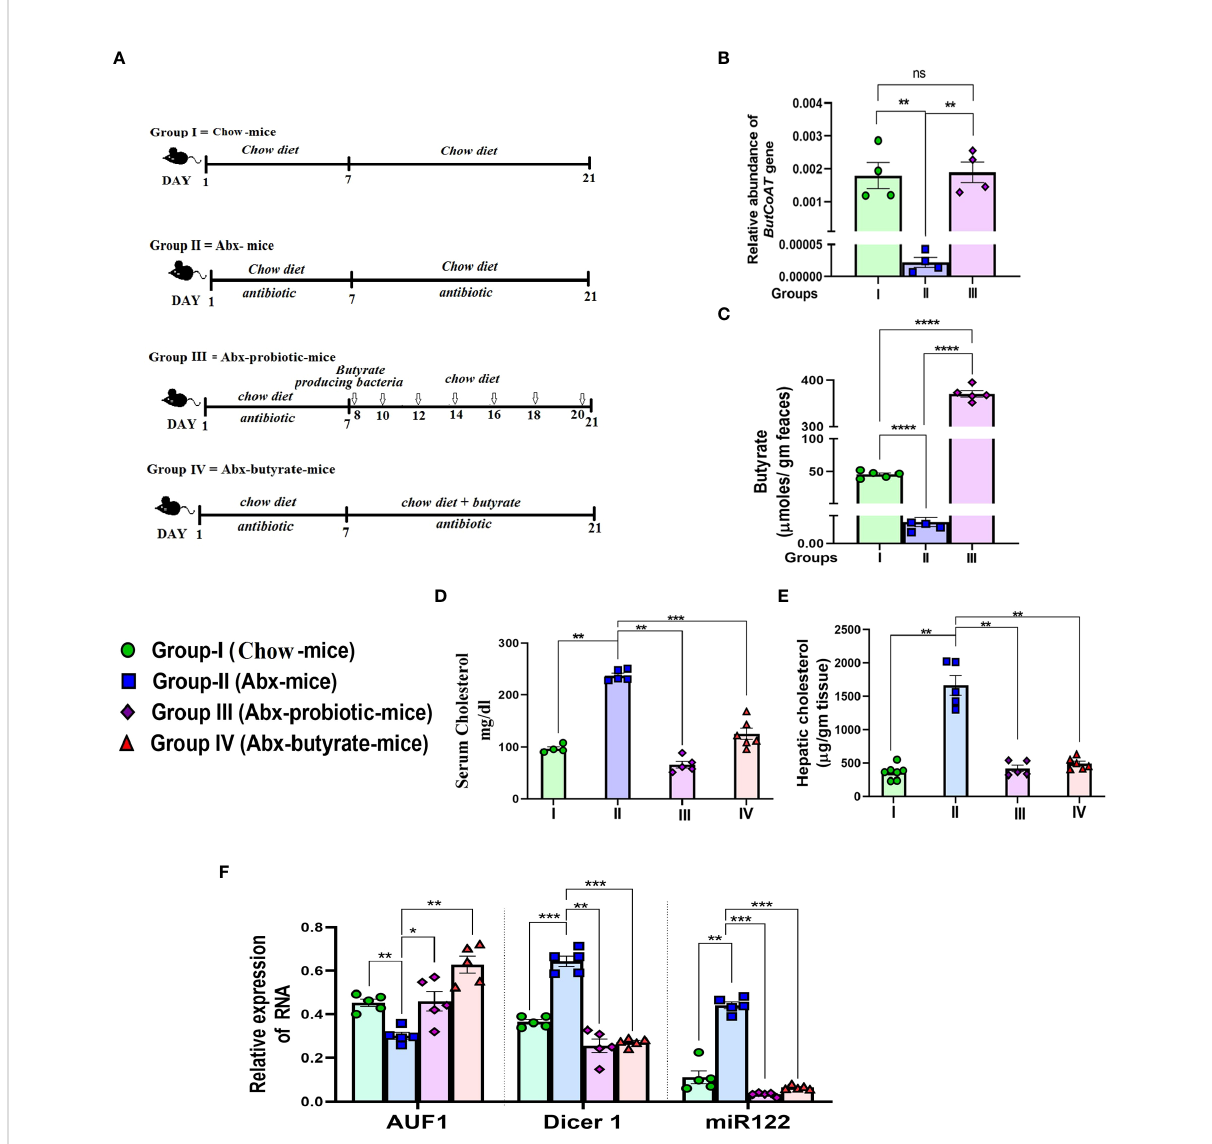
FIGURE 6 Effect of antibiotic treatment and subsequent probiotic treatment on fecal butyrate, serum and cholesterol, AUF1p40, Dicer1, and miR122 expression. Female mice were used for the study. Experimental design of the study: Group I = untreated chow-fed mice (untreated mice). Group II = mice receiving cocktail antibiotic and chow diet for 21 days (Abx mice). Group III = mice receiving cocktail antibiotic for the fi rst 7 days followed by bowel cleansing by PEG and administration of probiotics (10 7 cfu in 200 m l) via oral gavage/day, on every alternate day till 2 weeks (Abx probiotic mice). Group IV = Abx mice fed with 5% butyrate forti fi ed chow diet (w/w) from day 7 to day 21 (Abx butyrate mice) (A) . Blood, liver tissue, and fecal samples were collected on day 21. The relative abundance of the butCoAT gene in the feces measured by qPCR and normalized to 16S rRNA bacterial gene abundance (B) . Fecal butyrate (expressed in µg/g of feces) on day 21 estimated by LC-MS (C) . The serum cholesterol in mg/dl (D) and hepatic 903 cholesterol expressed in µg/g liver tissue (E) . Expression of hepatic AUF1 p40 , Dicer1, and miR122 904 determined by qPCR (F) . N = 5/group; data are presented as mean ±SE. The experiment was repeated twice. **** represents p<0.0001, *** represents p < 0.001, ** represents p < 0.01, * represents p < 0.05, and ns represents not signi fi